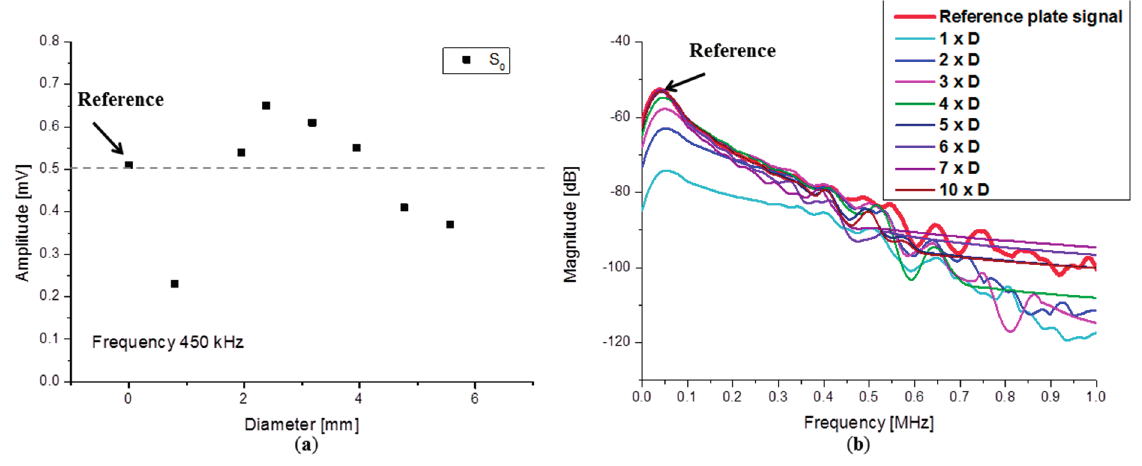
Figure 11. ( a ) Wavelet transform of reference case and ( b ) maximum A 0 amplitude as function of WG diameter and frequency.